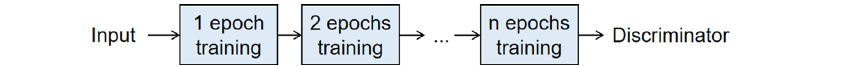
Fig. 13 The meaning of multiple training epochs. Multiple training epochs refer to sending data to a neural